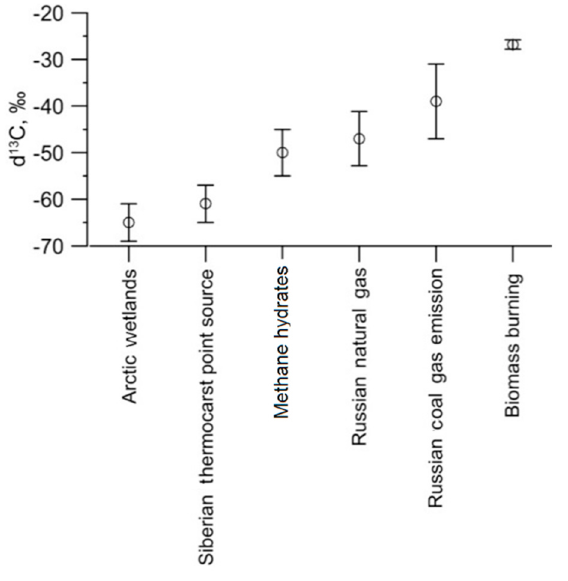
13 C in CH Figure 1. Range of δ 13 C in CH 4 for different sources according to [41] France et al. (2016). Figure 1. Range of δ 4 for different sources according to [41] France et al.